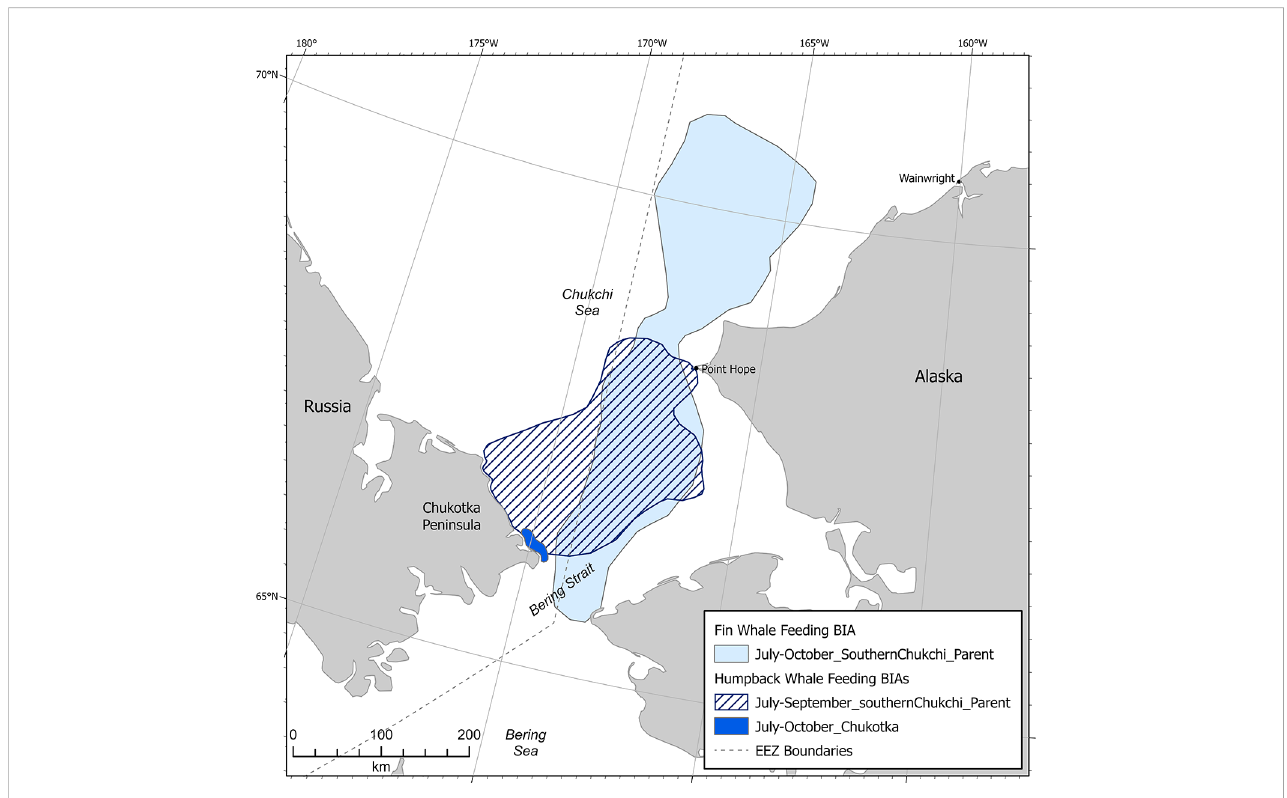
FIGURE 11 Arctic region humpback and fi n whale feeding BIAs (does not include child BIAs).